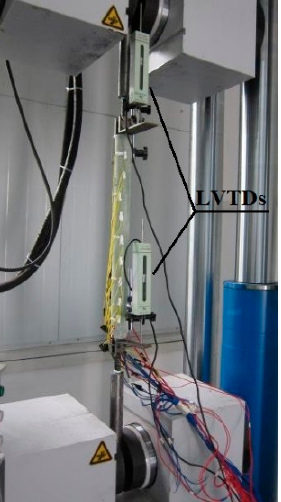
Figure 11. Loading equipment and measuring points.